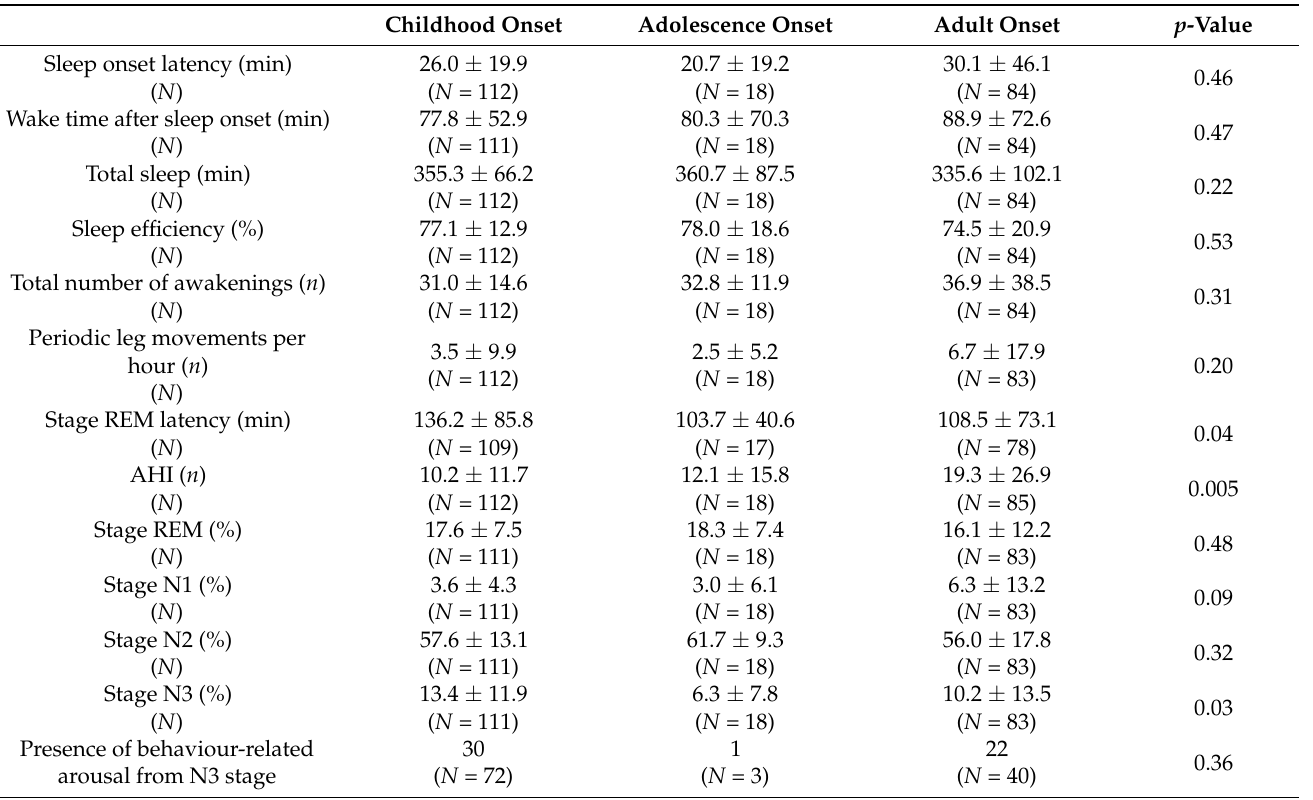
Table 4. vPSG characteristics of patients with NREM parasomnia split by age of onset ( p at 0.05/3 = 0.017). Childhood Onset Adolescence Onset Adult Onset